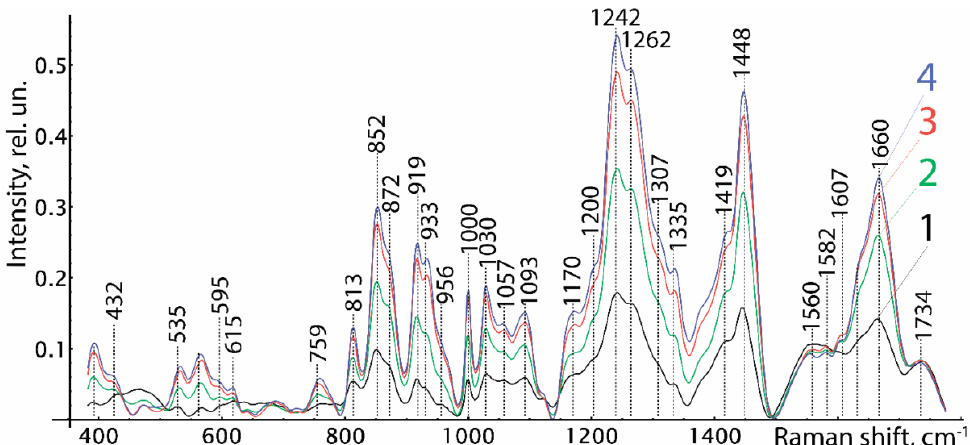
Figure 1. The average Raman spectra of the studied samples: 1—brefomatrix from spongy bone, 2—brefomatrix from cortical bone, 3—biomaterials from juvenile teeth with demineralization in 1.2 Н, 4— biomaterials from juvenile teeth with demineralization in 1.8 Н .